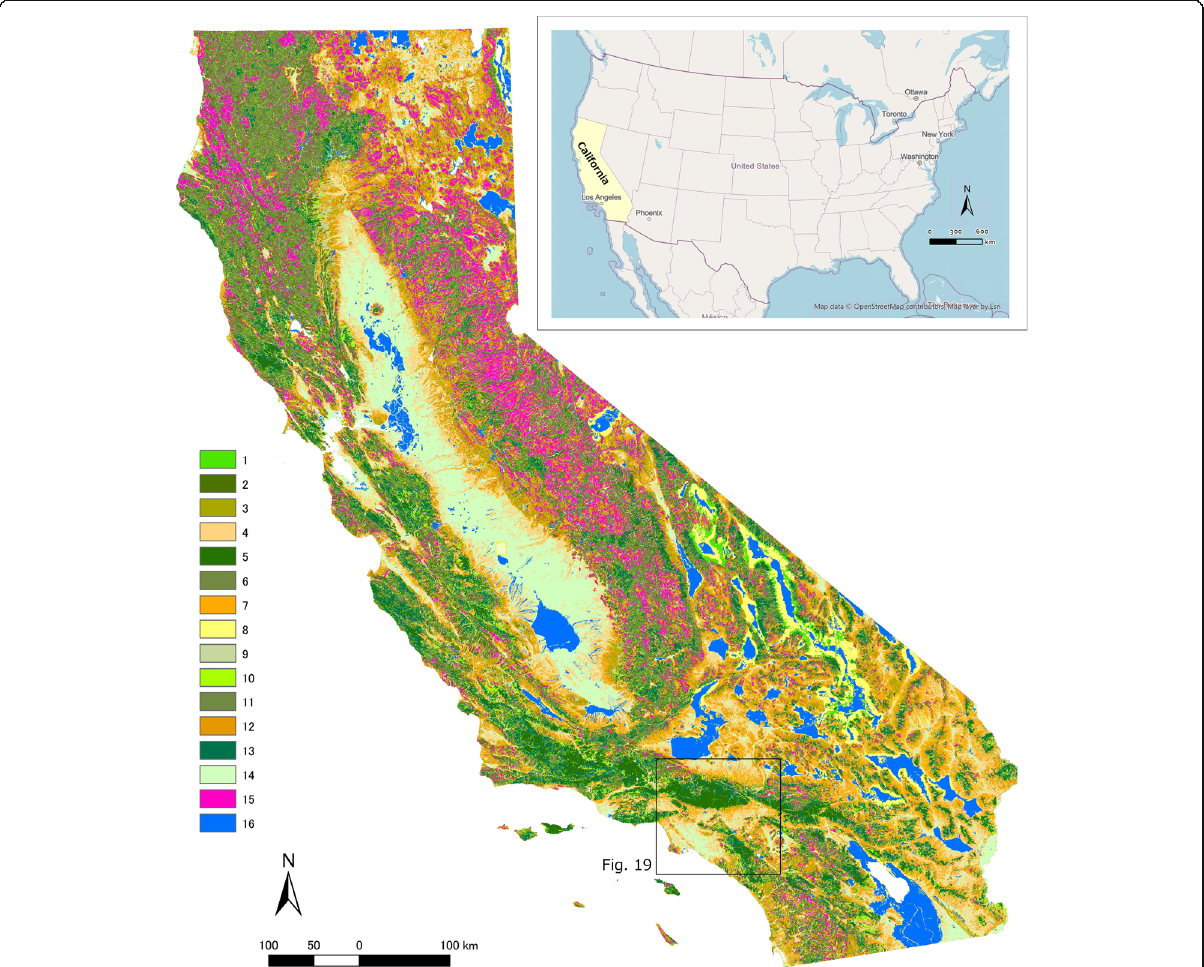
Fig. 18 Terrain classification of California using a 30 m DEM. The DEM was generated from 1" DEMs of the NED. No manmade terrain masks were used. The number of clusters is 15 and no grouping or reclassification was performed except for the addition of lowlands near the water level (blue). The other processes are the same as those in the Japanese